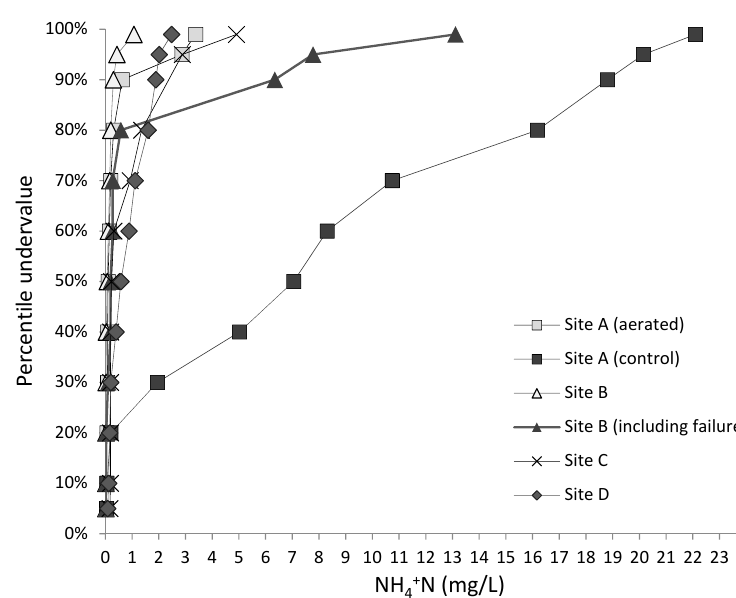
Figure 6. Ammonium removal robustness curves for all sites.